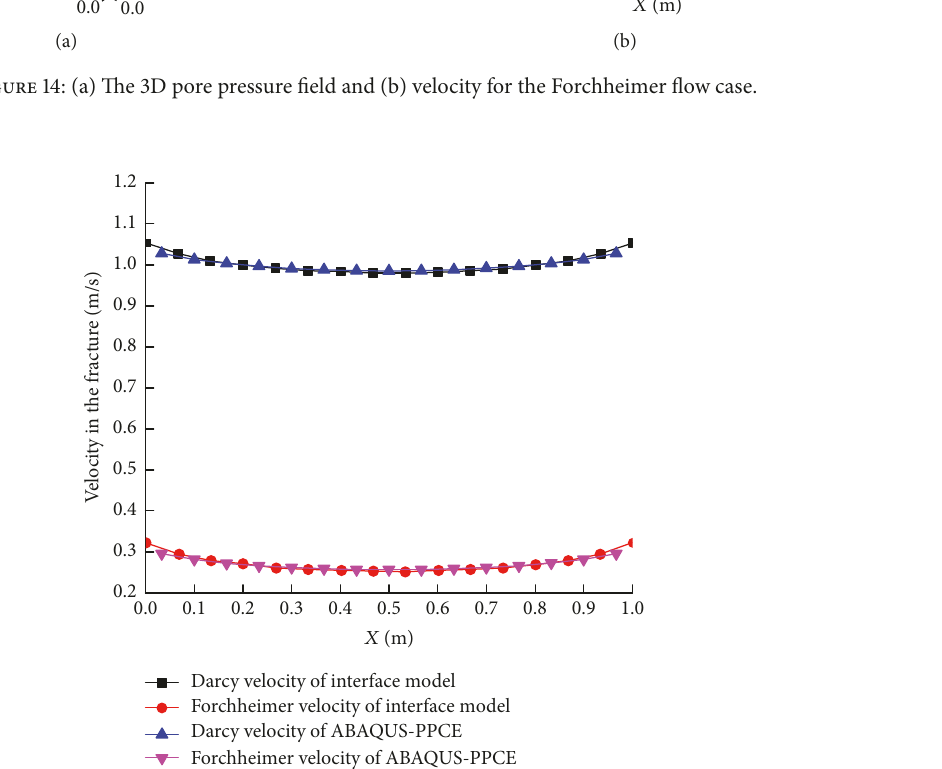
Figure 15: Darcy and Forchheimer flow velocity in the fracture given by the interface model and